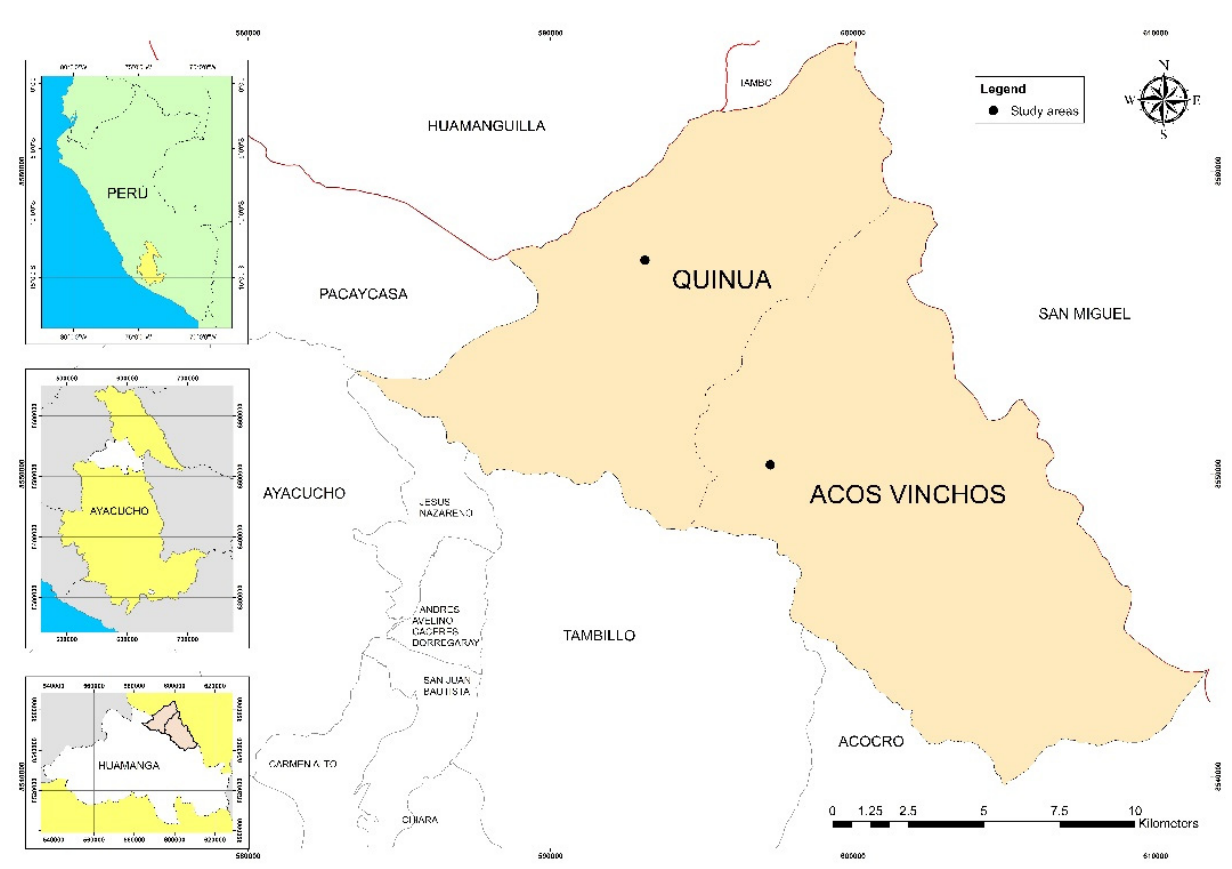
Figure 1. Location map of the study areas: Quinua and Acos Vinchos, province of Huamanga, Region Ayacucho-Peru.